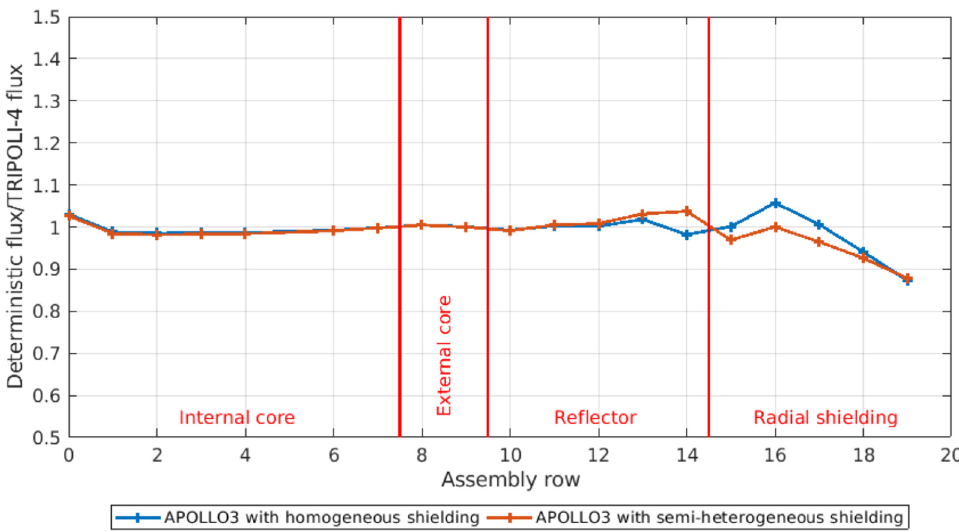
Fig. 17. Impact of the semi-heterogeneous of the radial shielding of ASTRID.